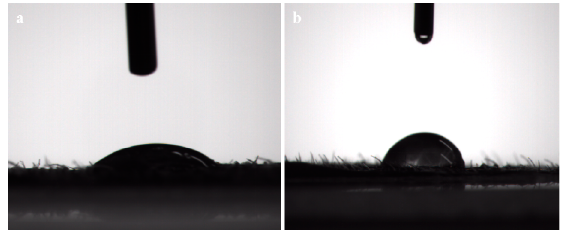
Figure 10. Contact angle of ( a ) the LC/PLA nano ‐ delivery system and ( b ) the commercial LC SC on cucumber leaves.